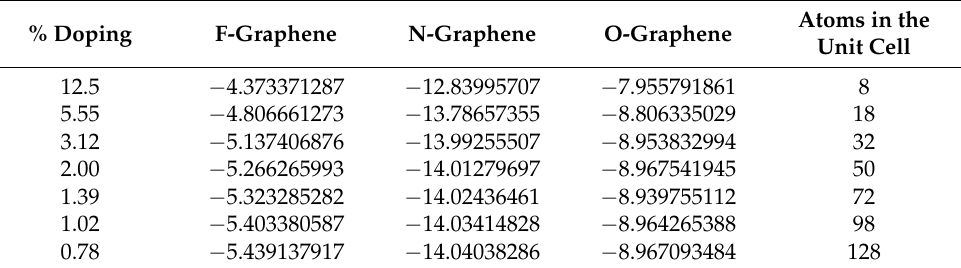
Table 1. Absorption energies (in eV) for each of the 21 cases of substitutional doping we considered after performing the structural relaxations.